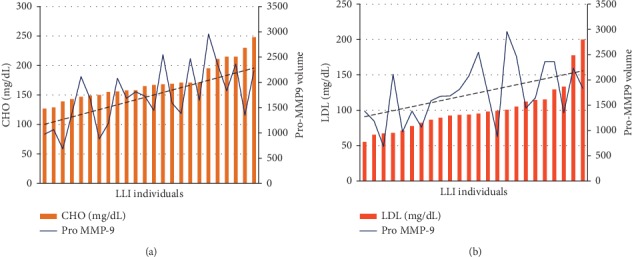
Histograms of Pro-MMP-9 (a, b) activity levels in the LLI group and hematological values of CHO (a) and LDL (b) to show the found correlations. The trend of the line in hematological parameters shows a positive correlation for both.